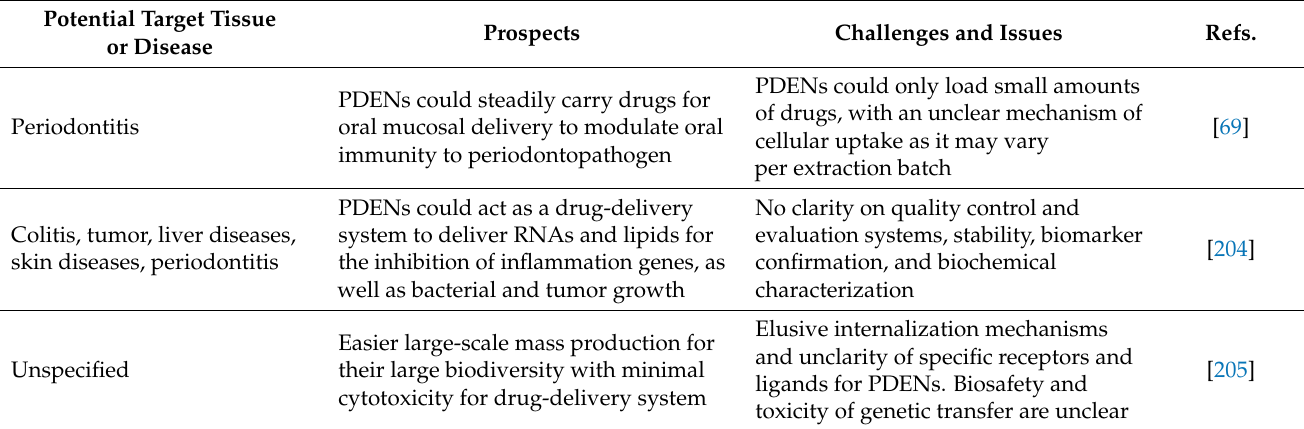
Table 4. Summary of review articles on PDENs in biomedical